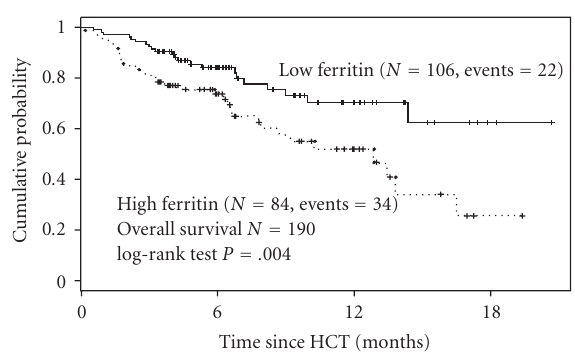
Figure 3: Prognostic impact of elevated pre-transplantation serum ferritin in patients undergoing myeloablative stem-cell transplanta- tion ( N = 190). Dashed line represents patients with serum ferritin over 1000ng/ml. Adapted from